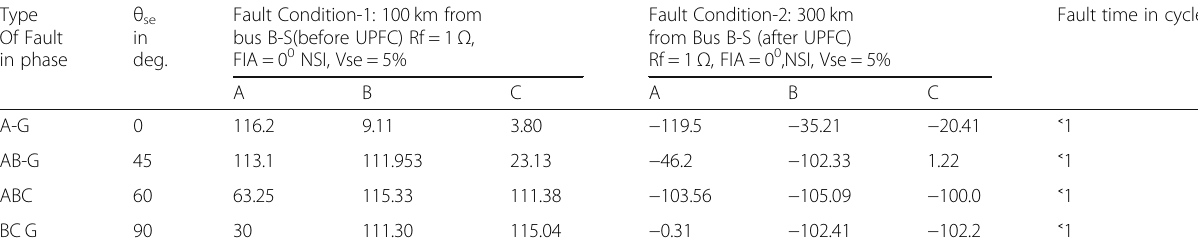
Table 3 DSE performance variation, fault time of variation in θ se at Vse = 5% of UPFC Type Of Fault in phase deg.